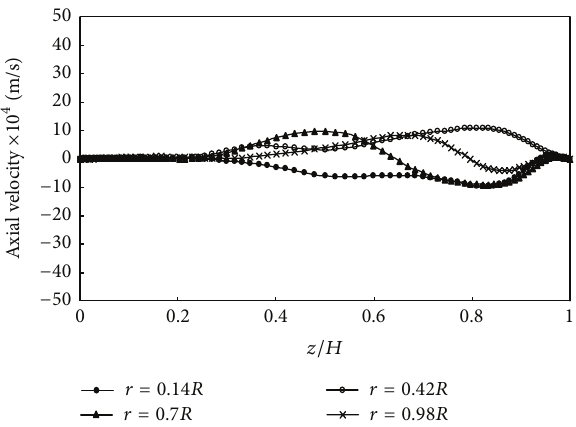
Figure 16: Profile of axial velocity along axial direction.